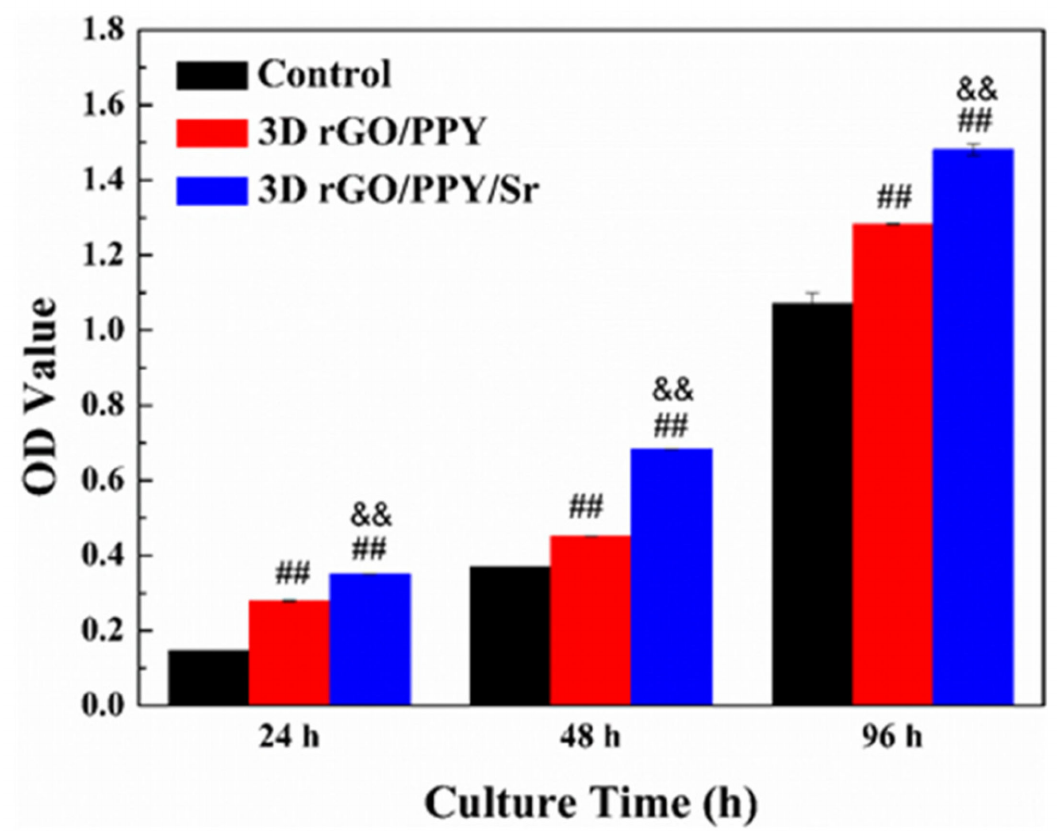
Figure 2. The results of the MTT assay for 3D rGO/PPY and 3D rGO/PPY/Sr scaffolds after co-culture with MC3T3-E1 cells at 24 h, 48 h, and 96 h, respectively. (## p < 0.05 3D rGO/PPY vs. control group, && p < 0.05 3D rGO/PPY/Sr vs. 3D rGO/PPY